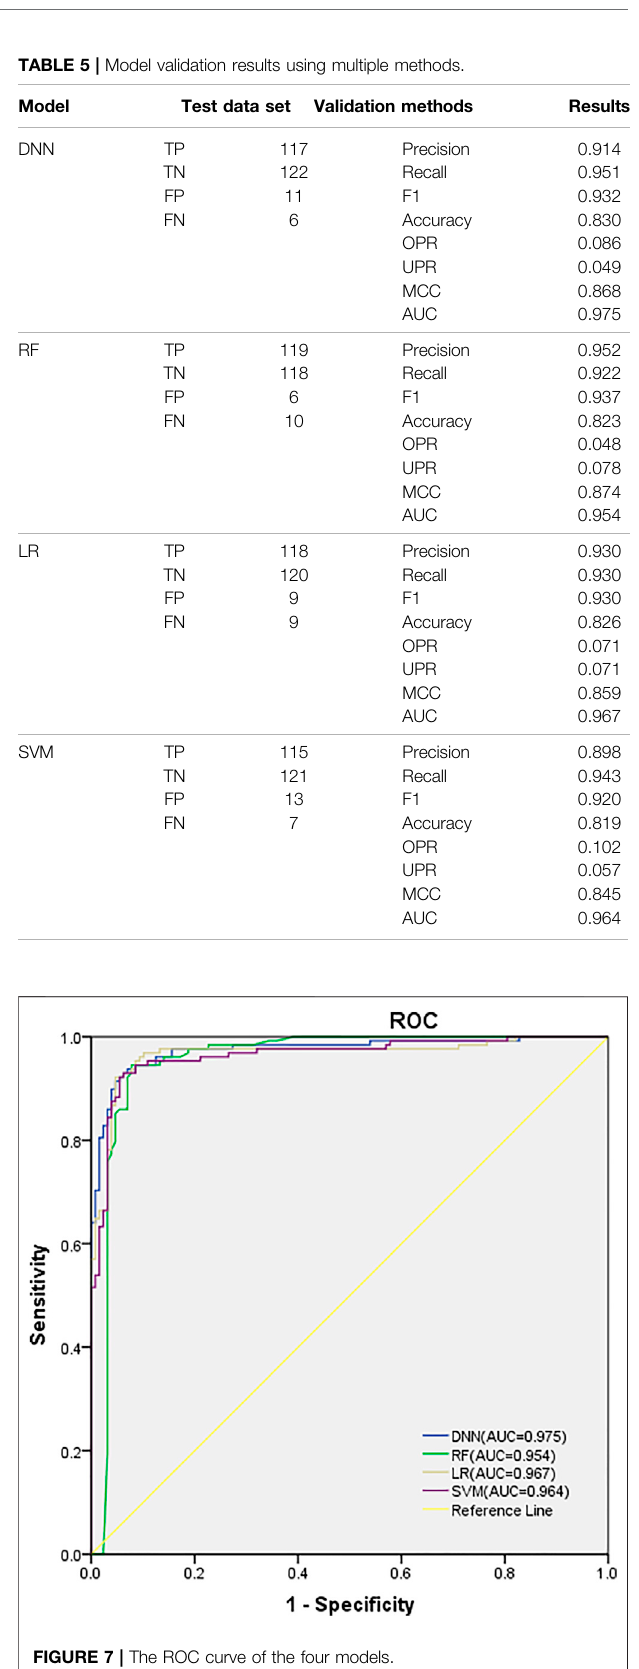
FIGURE 7 | The ROC curve of the four